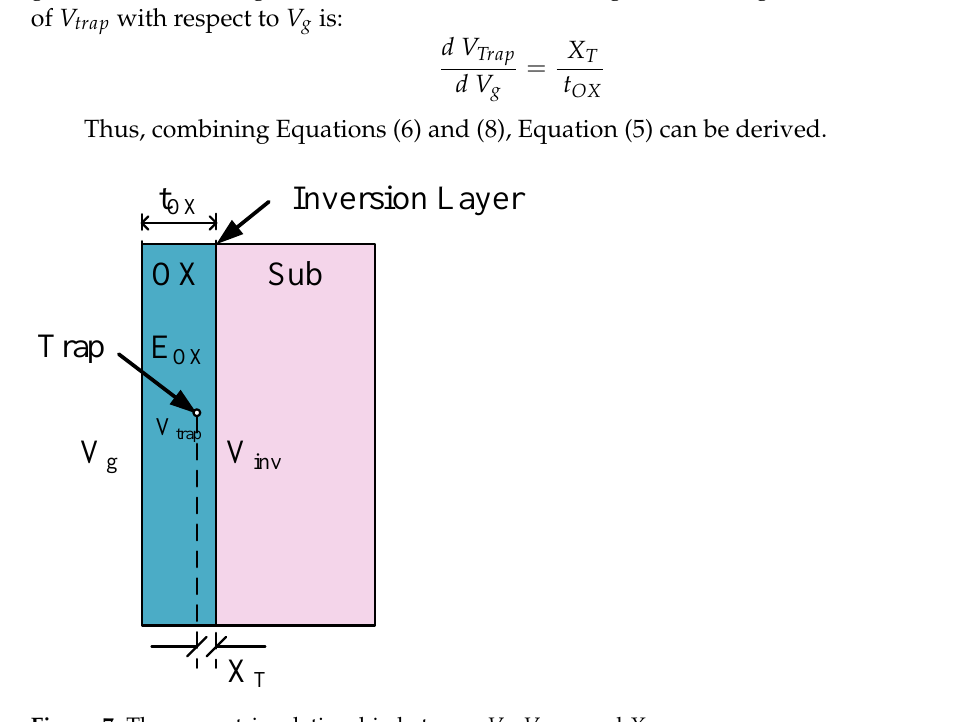
Figure 7. The geometric relationship between V g , V Trap , and X T .